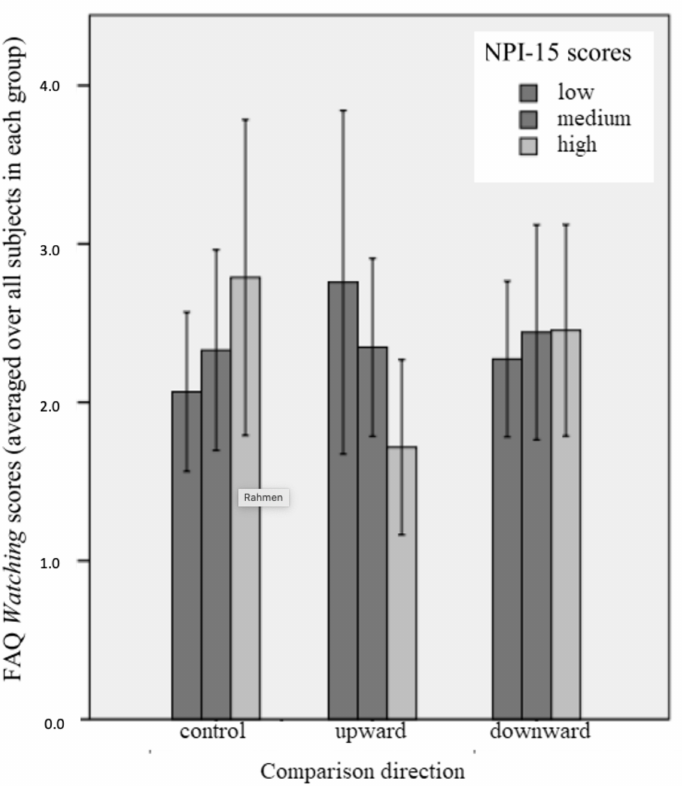
Figure 1. FAQ Watching mean scores depending on group assignment at three levels of NPI-15 scores. Low scores are defined as scores of mean − 1 SD and lower. Medium scores are defined as scores above mean − 1 SD, but below mean + 1SD. High scores are defined as scores of mean + 1 SD and higher. Error bars represent +/ − 1